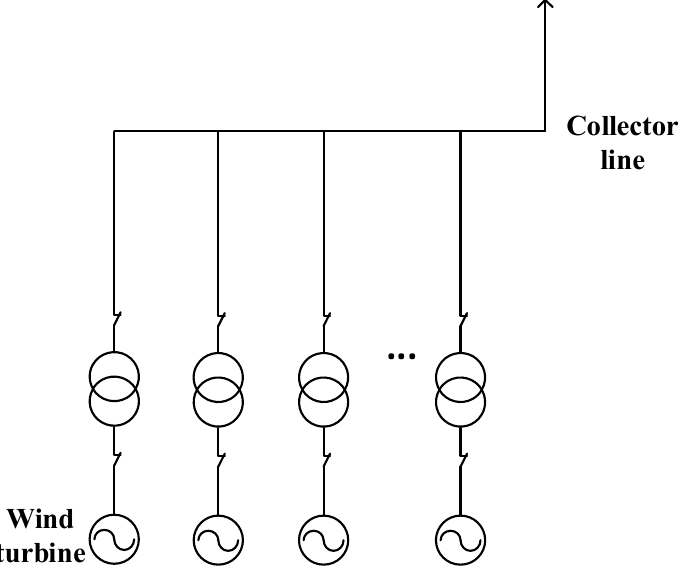
Figure 2. Power collector system of the offshore wind farm.